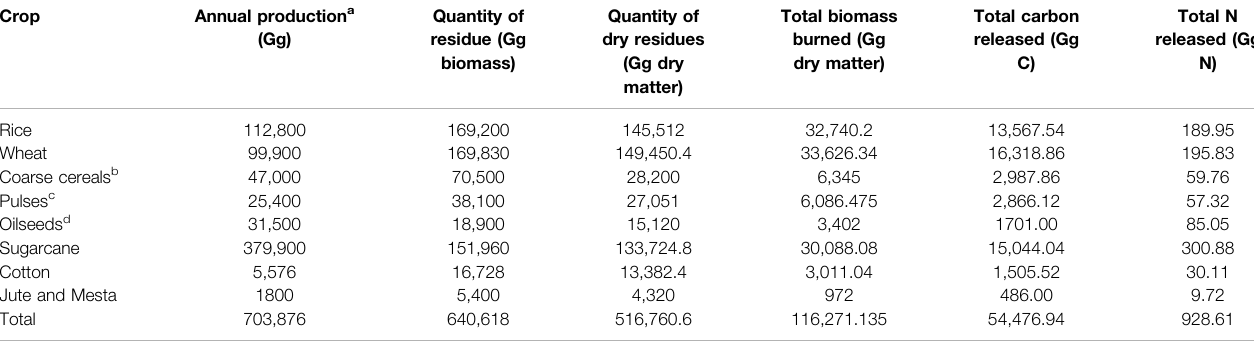
TABLE 2 | Crop-wise production, crop residue generated, total carbon and nitrogen released in India (2017 – 18). Crop